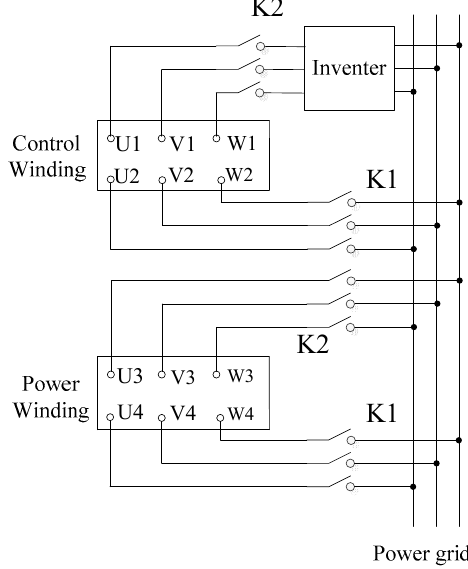
Figure 10. The port wiring diagram of the prototype when it is overall